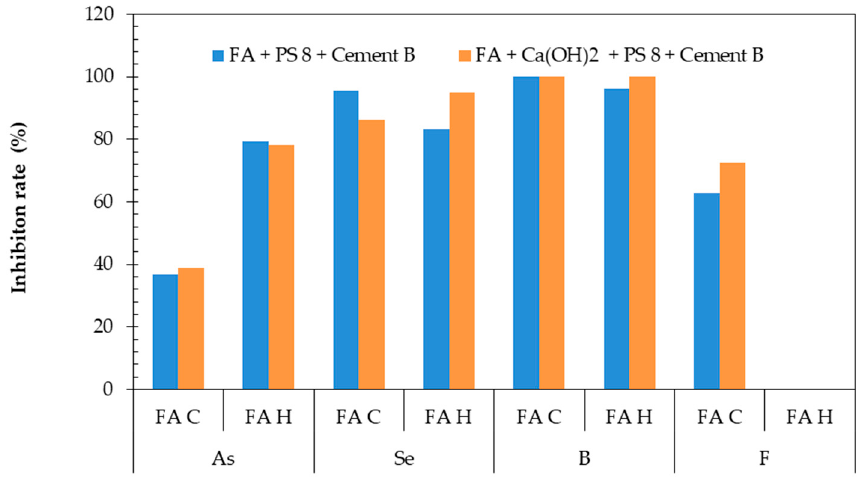
Figure 6. Inhibition rate of the mixed additives on the As, Se, B and F leachate concentrations.